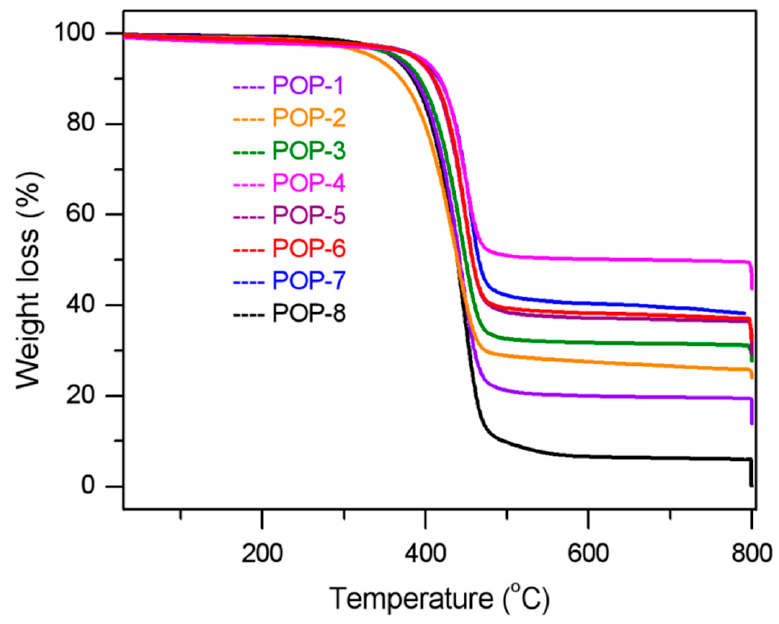
Figure 4. Thermogravimetric analysis (TGA) curves of the prepared TiO 2 /POP particles.